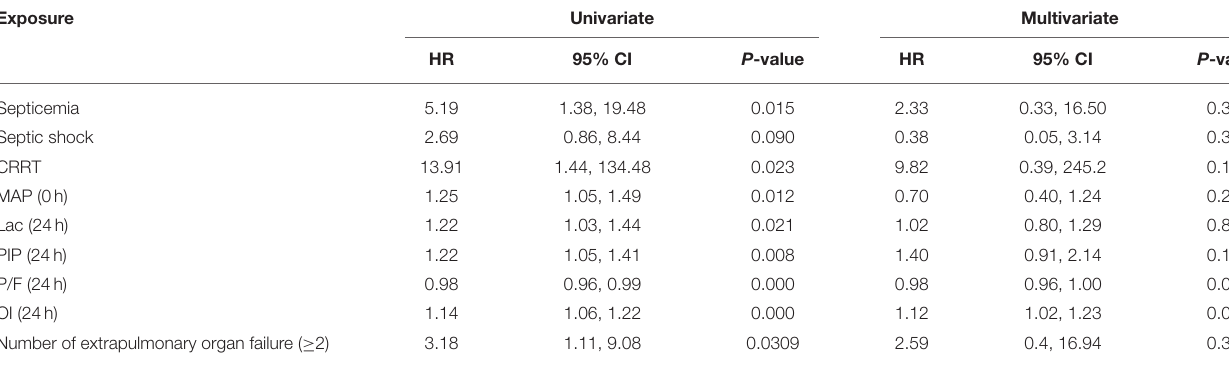
TABLE 4 | Univariate and multivariate Cox regression analyses results of independent variables associated with a 30-day mortality. Exposure Univariate Multivariate HR 95% CI P -value HR 95% CI